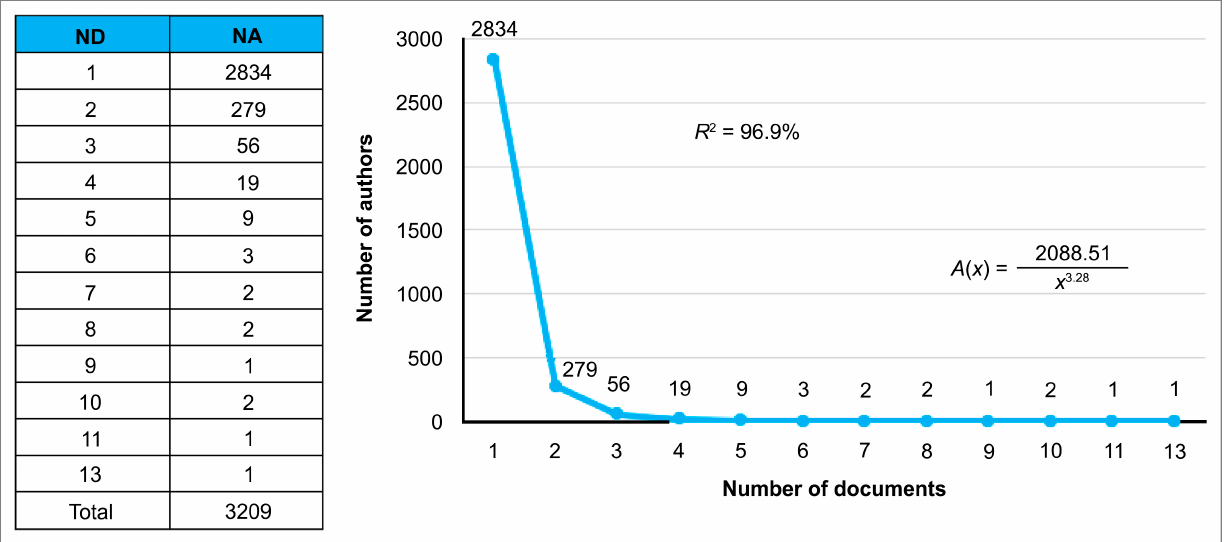
Figure 12. Productivity of authors according to number of published papers using Lotka’s inverse model. Note : ND: number of documents, NA: number of authors.